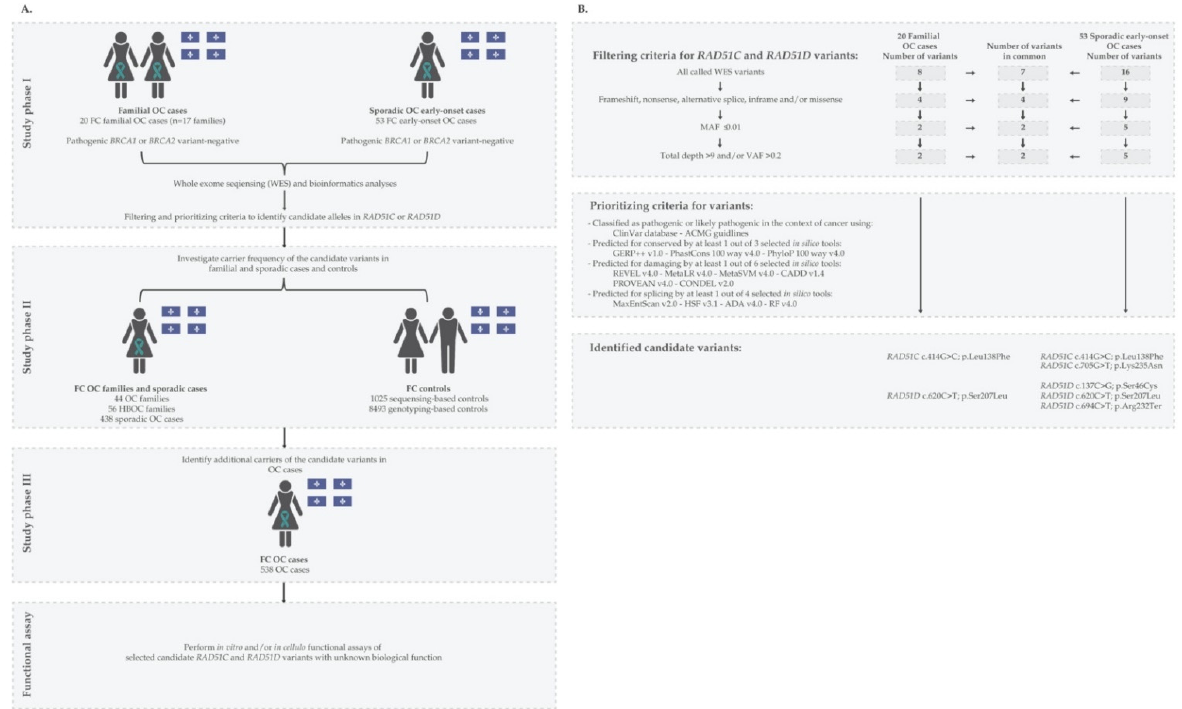
Figure 1. Study design and criteria for identifying candidate variants in RAD51C and RAD51D . ( A ) Schematic diagram summarizing phase I of the study for identifying candidate variants in ovarian cancer (OC) cases, phase II of the study for determining the carrier frequency of the candidate variants in familial and sporadic OC cases, Hereditary Breast and Ovarian Cancer (HBOC) syndrome families and controls from the French Canadian (FC) population of Quebec, and phase III of the study for identifying additional carriers; teal ribbon signifies women with OC; and diagrams contain provincial flag of Quebec denoting geographic ascertainment of cases and controls; and ( B ) Schematic diagram presenting the filtering and prioritizing criteria applied to identify candidate variants (see Table S5). Variants were prioritized using different in silico tools for conservation: Genomic Evolutionary Rate Profiling v1.0 (GERP++ v1.0 (score ≥ 2.0)); Phylogenetic p value v4.0 of 100 vertebrates (PhyloP 100 way v4.0 (score ≥ 0.2)) and PHAST Conservation v4.0 of 100 vertebrates (PhastCons 100 way v4.0 (score ≥ 0.4)); for predicting damaging effects based on their best predictive performance: Rare Exome Variant Ensemble Learner v4.0 (REVEL v4.0 (score ≥ 0.4)); Meta-analytic Logistic Regression v4.0 (MetaLR v4.0 (score ≥ 0.4)); Meta-analytic support Vector Machine v4.0 (MetaSVM v4.0 (score ≥ 0.0)); Combined Annotation Dependent Depletion v1.3 (CADD v1.4 (Phred score ≥ 20)); Protein Variation Effect Analyzer v4.0 (PROVEAN v4.0 (score ≥ − 2.5)); and CONsensus DELeteriousness v2.0 (CONDEL v2.0 (score ≥ 0.4)); and for affecting alternative splicing: Maximum Entropy Estimates of Splice junction strengths v2.0 (MaxEntScan v2.0); Human Splicing Finder v3.1 (HSF v3.1); and two different Database Splicing Consensus Single Nucleotide Variant (dbscSNV) in silico tools: AdaBoost v4.0 (ADA v4.0 (score ≥ 0.4)) and Random Forest v4.0 (RF v4.0 (score ≥ 0.4)) (see Materials and Methods Section